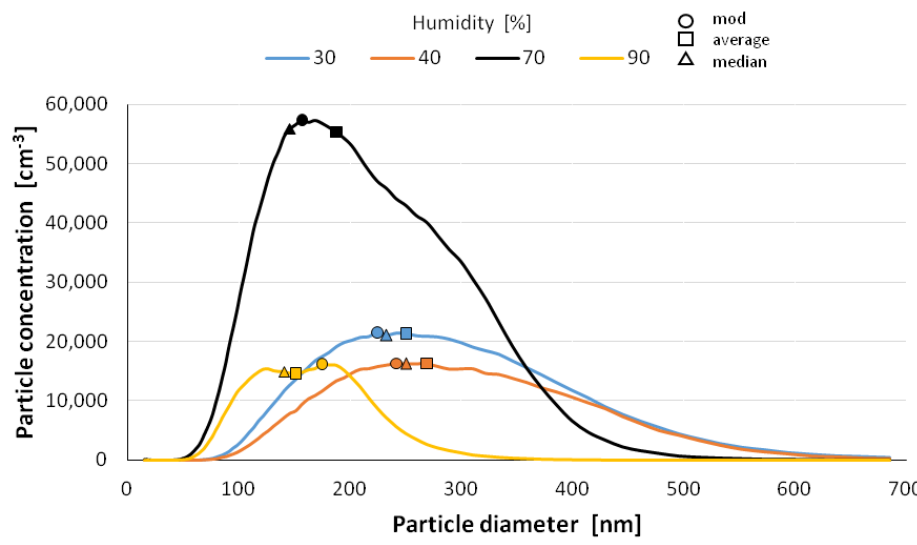
Figure 8. Size distribution of superfine particles 7.5 min after atomization.